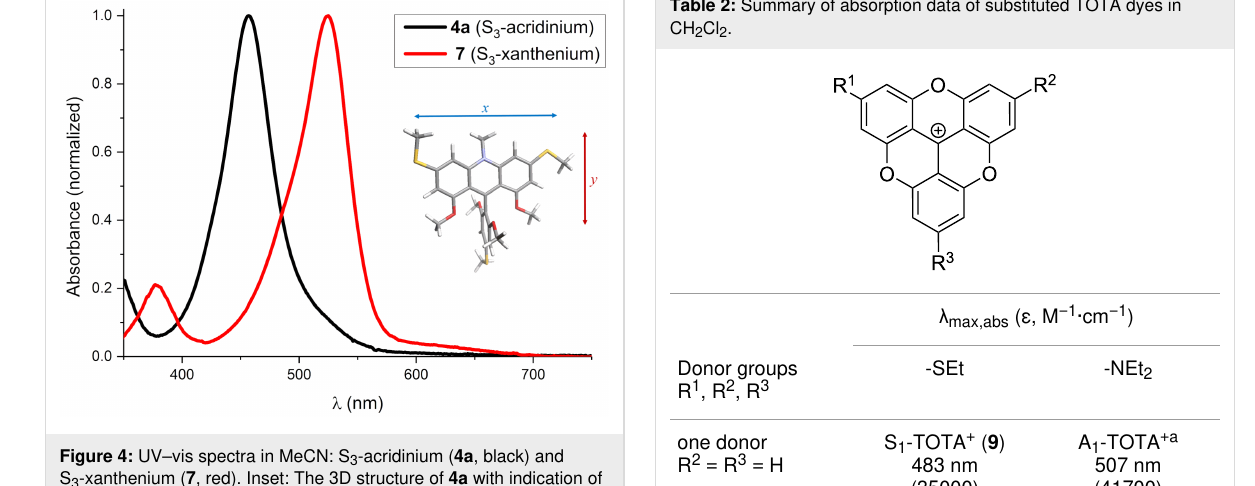
The three sulfur-substituted trioxatriangulenium dyes 6 , 8 , and